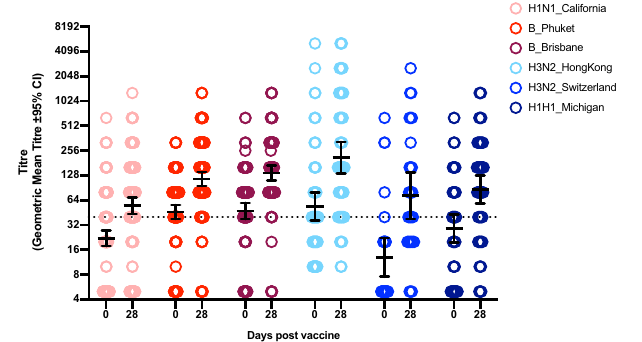
Fig. 2 Antibody response pre- (D0) and post- (D28) vaccine for each strain. Data is expressed as GMT ± 95% con fi dence intervals. Temporal differences for each strain are considered signi fi cant if con fi dence intervals (CI) do not overlap. Dotted horizontal line represents a GMT of 1:40, indicative of seroprotection. GMT: geometric mean